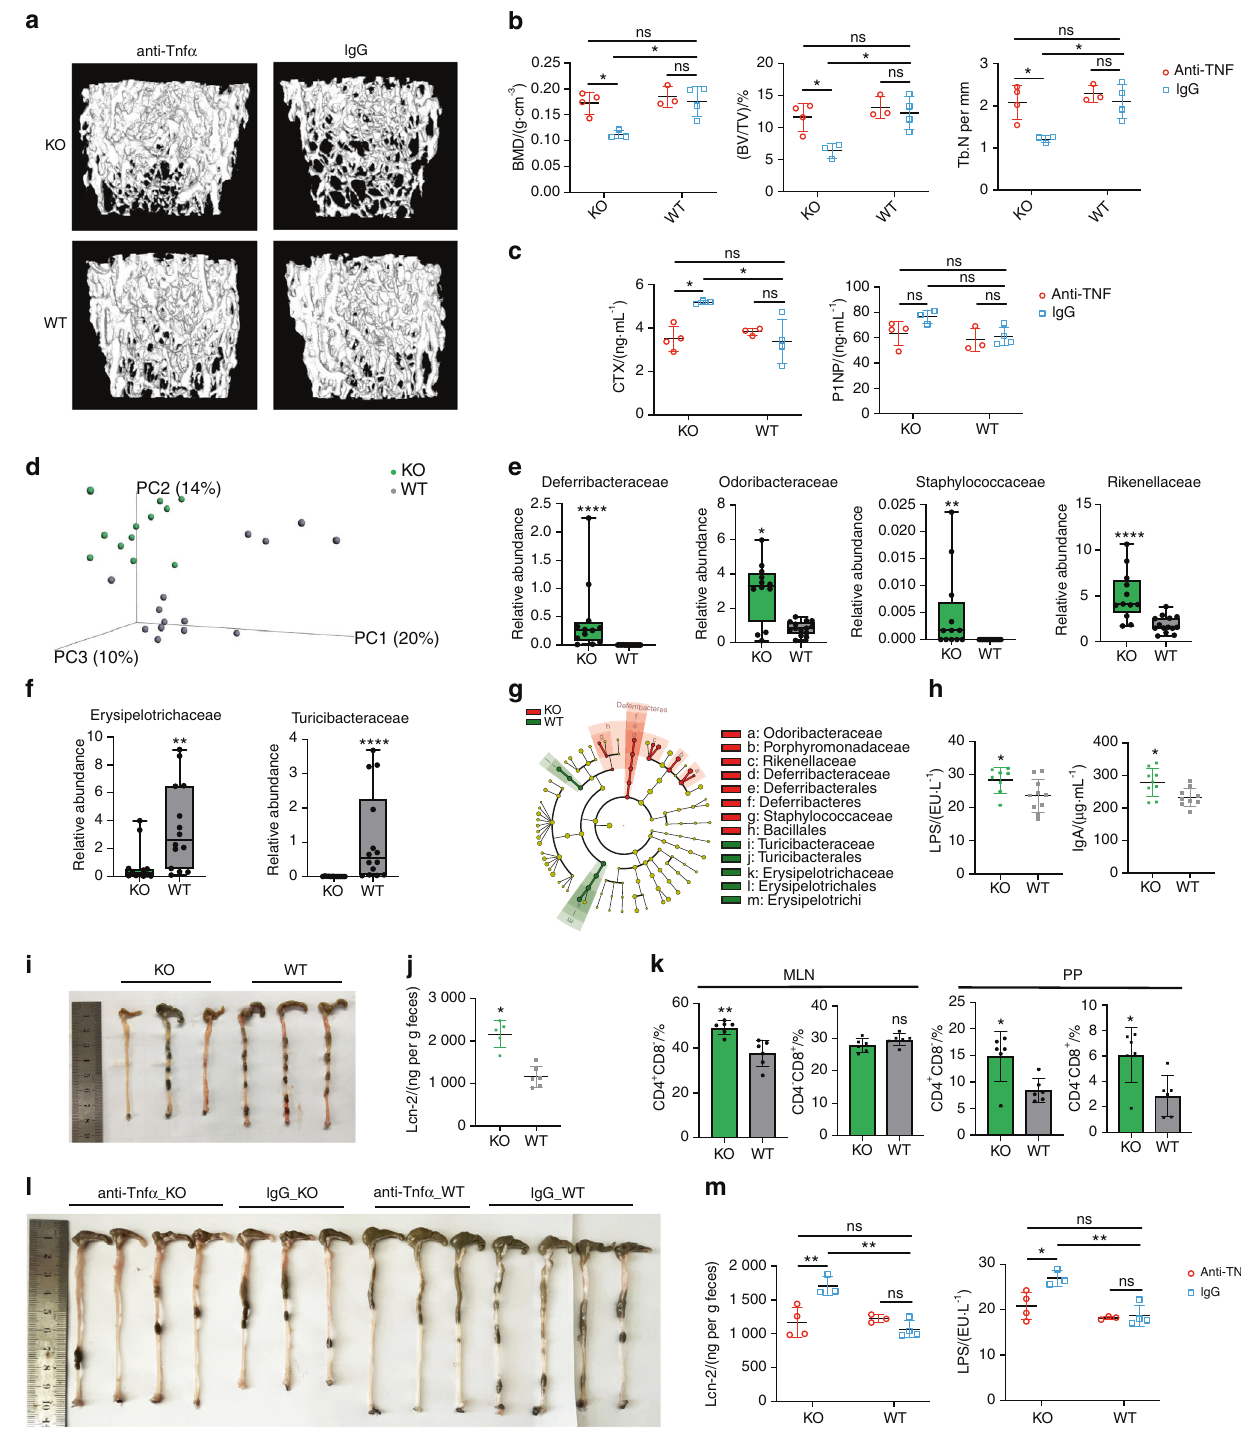
Fig. 3 The anti-TNF α therapy experiment and the altered gut microbiota composition and intestinal in fl ammation in TLR9 − / − mice. a – c , l , m The anti-TNF α therapy experiment. In all panels, n = 3 in IgG_KO and anti-TNF α _WT group; n = 4 in anti-TNF α _KO and IgG_WT group. a Representative 3D μ CT reconstructions of femurs from each group. b Trabecular BMD, BV/TV, and Tb. N of femurs in each group. c Serum CTX and P1NP levels. d 3D PCoA of 16S rRNA sequencing of fecal microbiota from 8-week sex-matched TLR9 − / − (KO) and wildtype (WT) mice. Each dot represents a fecal microbiota from one mouse. KO, n = 12; WT, n = 14. e – f Relative abundance of the signi fi cantly upregulated families ( P < 0.05) in KO ( e ) and WT ( f ) group. Boxplots represent median and quantiles. g Cladogram of Linear discriminant analysis Effect Size (LEfSe) analysis showing the differentially abundant bacteria between KO and WT groups. h Circulating LPS and IgA levels. n = 8 – 10 per group. i Large intestines of 8-week-old male KO and WT mice. j Fecal Lcn-2 levels. KO, n = 5; WT, n = 6. k Flow cytometry analysis of T cell populations in MLN and PP. n = 6 per group. The numbers represent the frequencies in total MLN or PP cells. l , m Ameliorated gut in fl ammation after anti-TNF α therapy. l Large intestines from all treated mice. m Serum LPS and fecal Lcn-2 levels. Mann – Whitney t test was used in e and f . Two-way ANOVA with multiple comparisons (Turkey ’ s test) were used in b, c and m . An unpaired two-tailed t-test was applied in other panels. Error bars represent the s.d. * P < 0.05, ** P < 0.01, **** P < 0.000 1 and ns P >